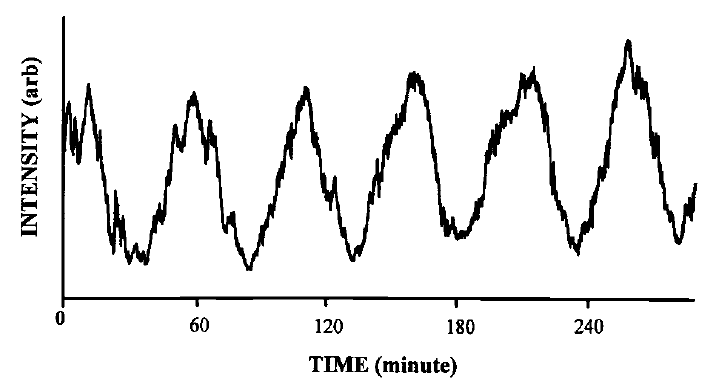
Figure 16. Temporal dependence of the detector output (of Figure 15) reveals fringe behavior [37].